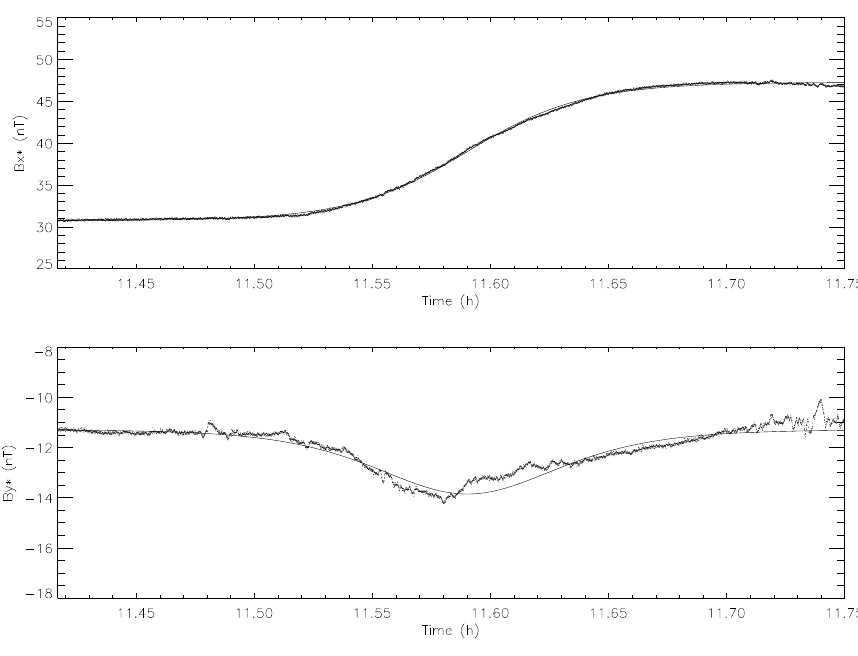
Fig. 15. The fit results for an SI event on 26 August 2002. Table 5. Estimated propagation speeds of the disturbances using timing between Cluster spacecraft pairs. Columns are the event number, spacecraft pair used (S/C), separation of spacecraft in the X and Y directions, the propagation speed calculated using time delays between two Cluster satellites ( V prog ), the propagation speed calculated using the correlation analysis ( V corr ), the difference between the speeds obtained using the two methods (diff) and the propagation speed of a shock or pressure discontinuity ( V S